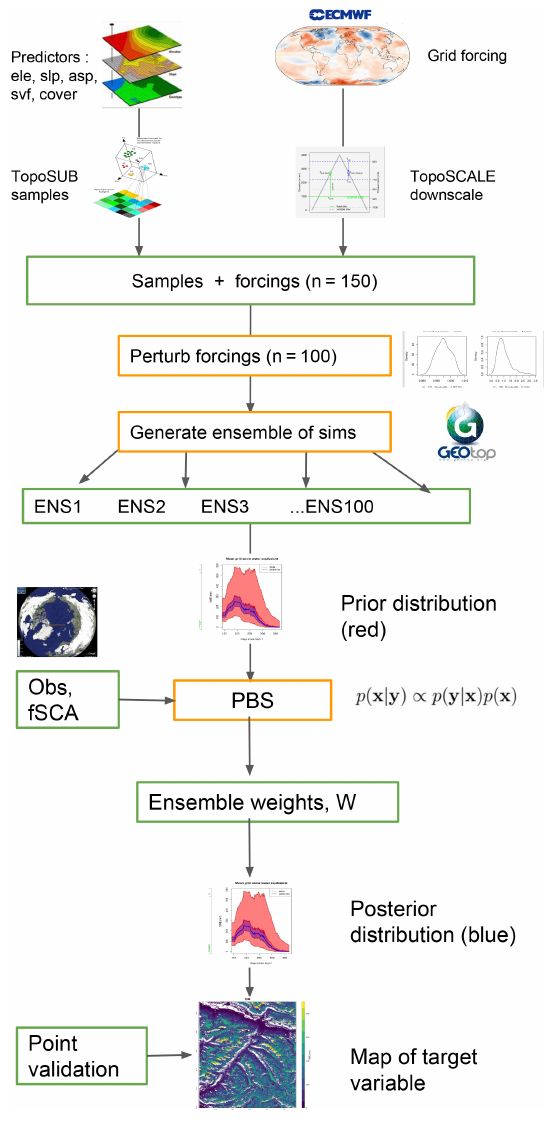
Figure 1. Schematic of the modelling set-up. Input predictors are usually elevation (ele), slope (slp), aspect (asp), sky view factor (svf) and land cover